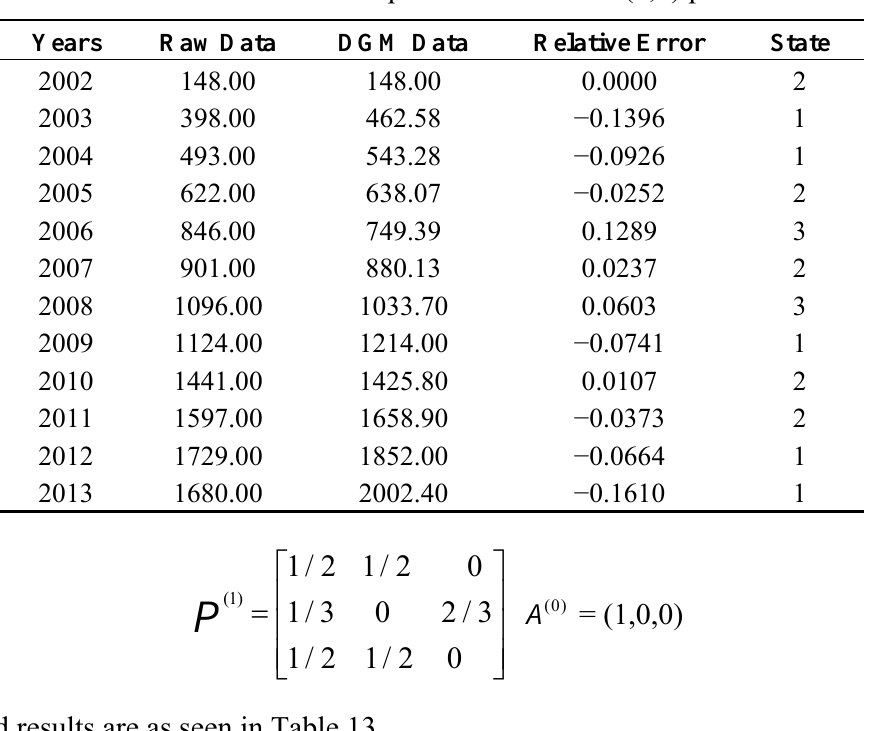
Table 12. Results of the Markov process with DGM (1,1) prediction data.